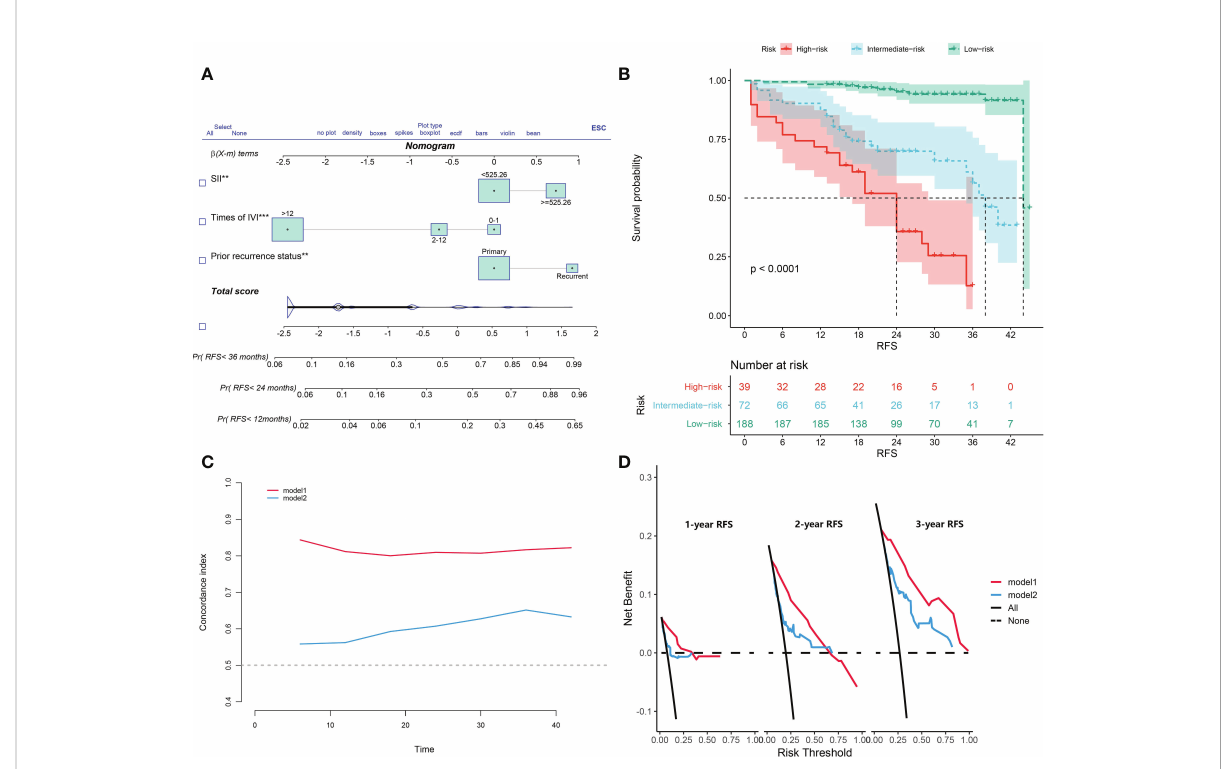
FIGURE 4 (A) The constructed nomogram for predicting recurrence-free survival of non-muscle-invasive bladder cancer patients after transurethral resection of the bladder tumor. (B) Kaplan-Meier curves of low-risk, intermediate-risk, and high-risk groups based on the prediction of the nomogram. (C) Harrell ’ s concordance index for 1-, 2-, and 3-year recurrence-free survival of two models. (D) Decision-curve analyses demonstrate the net bene fi t of using the models. Model 1, the nomogram; model 2, model based on age, gender, T category, prior recurrence status, pathology grade, tumor number, and maximum tumor diameter. IVI, intravesical instillation; SII, systemic immune-in fl ammation index = platelet*